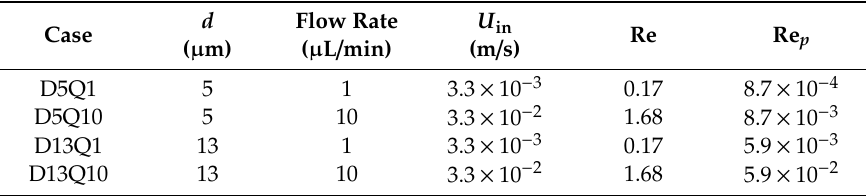
Figure 2. ( a ) Cross-sectional shape of the rhombic microchannel utilized in the numerical simulation. The dashed circle represents a spherical particle located in the center of the channel. ( b ) Power-law model based on the experimental data [23] to simulate the viscosity of the PEO500 solution. Table 1. Flow and particle parameters in the numerical